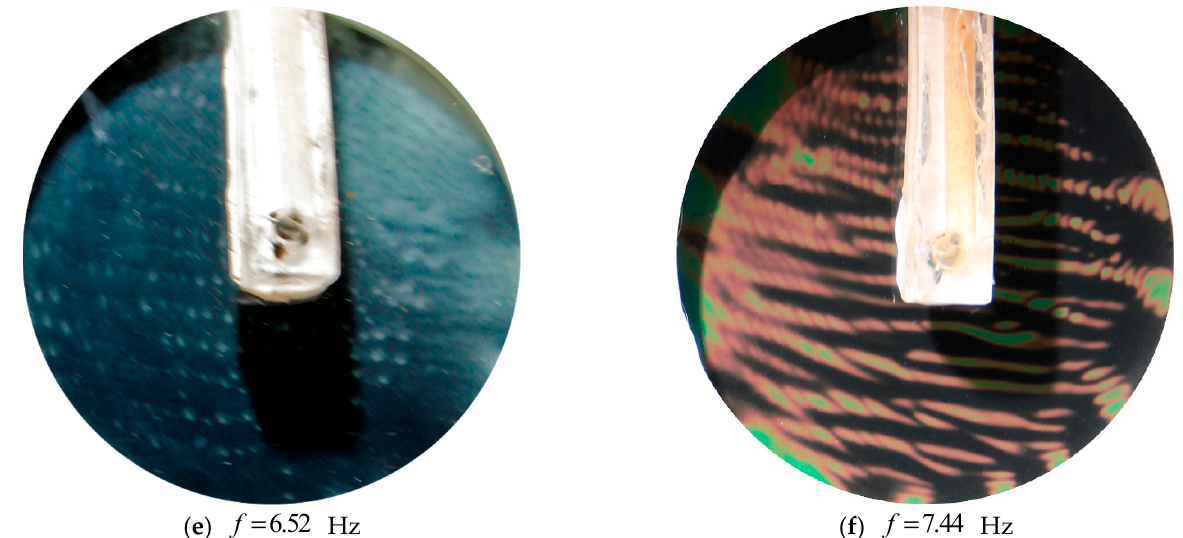
Figure 4. The distribution of the calliroscope particles at the bottom of the layer below ( a ) and above ( b ) the threshold of the thermal vibrational convection excitation. The distribution of the Resin Amberlite particles in the layer with a thickness of h = 0.42 cm below ( c , d ) and above ( e ) the excitation of the thermal vibrational convection. Convective structures in the supercritical region, visualized using the thermochromic film ( f ), h = 0.32